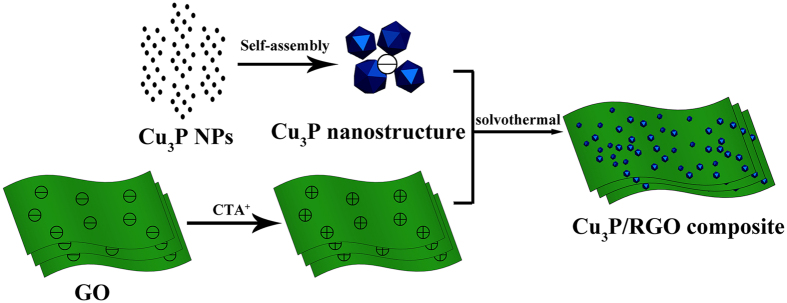
The Schematic layout of the experimental process for the preparation of Cu3P/RGO nanocomposite.